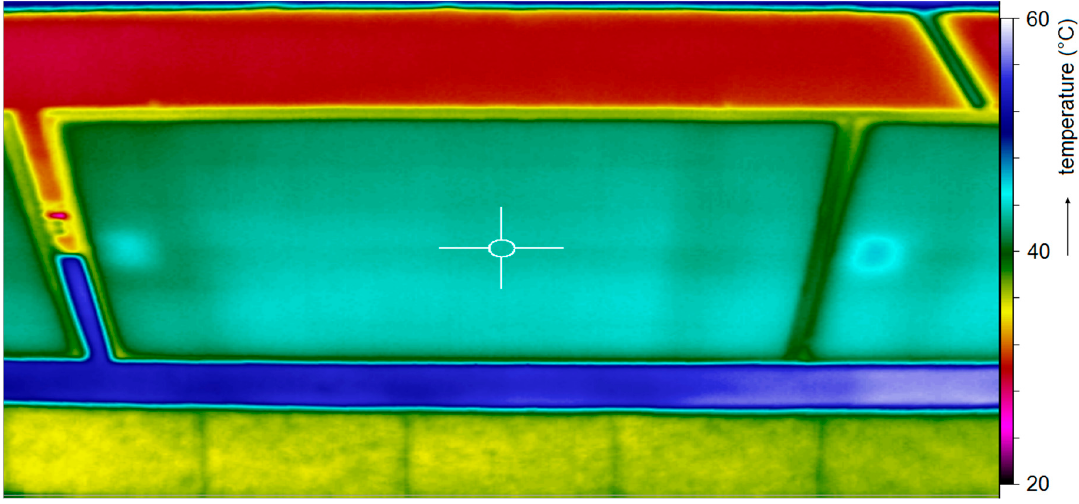
Figure 3. Typical PV panel image from the infrared camera.